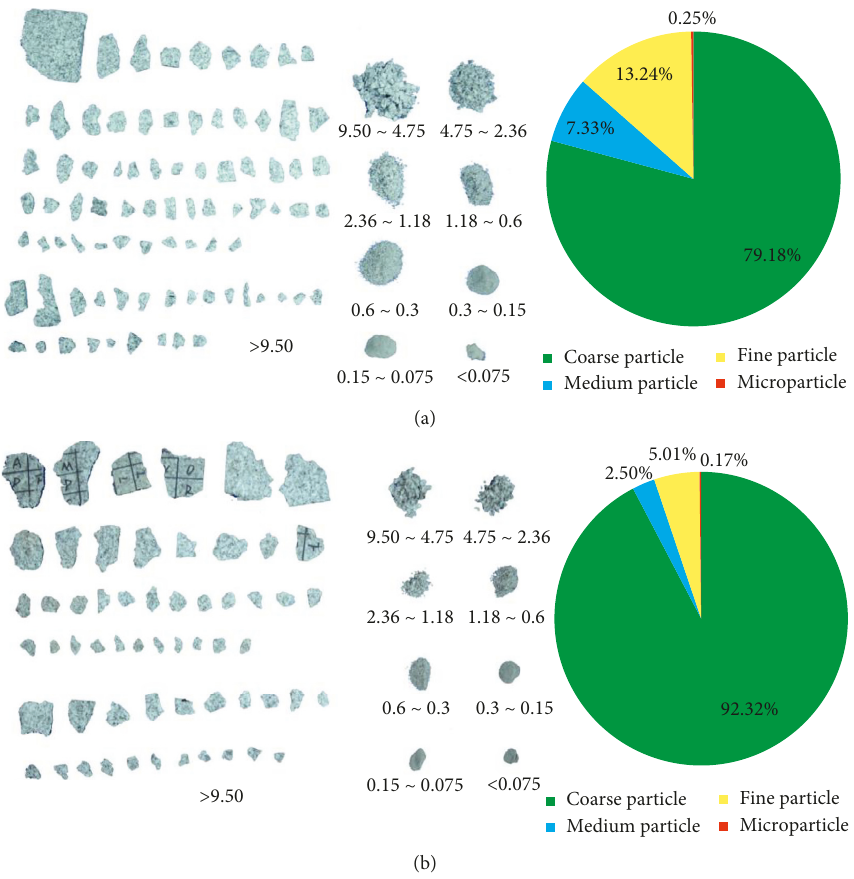
Figure 15: The failure form of the tested specimens under different support failure timings: (a) σ (c) σ 1 / σ max (cid:31)